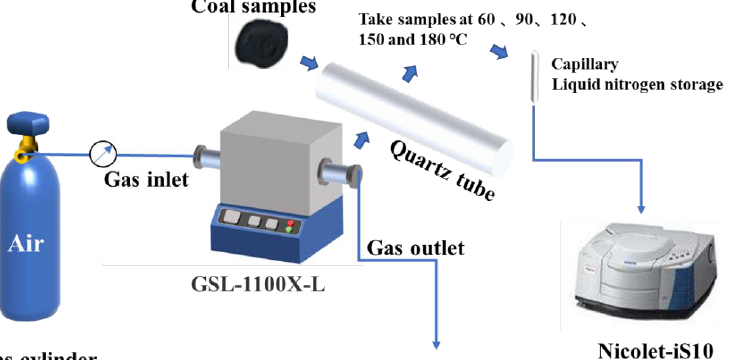
Figure 1. Sample collection and FTIR test